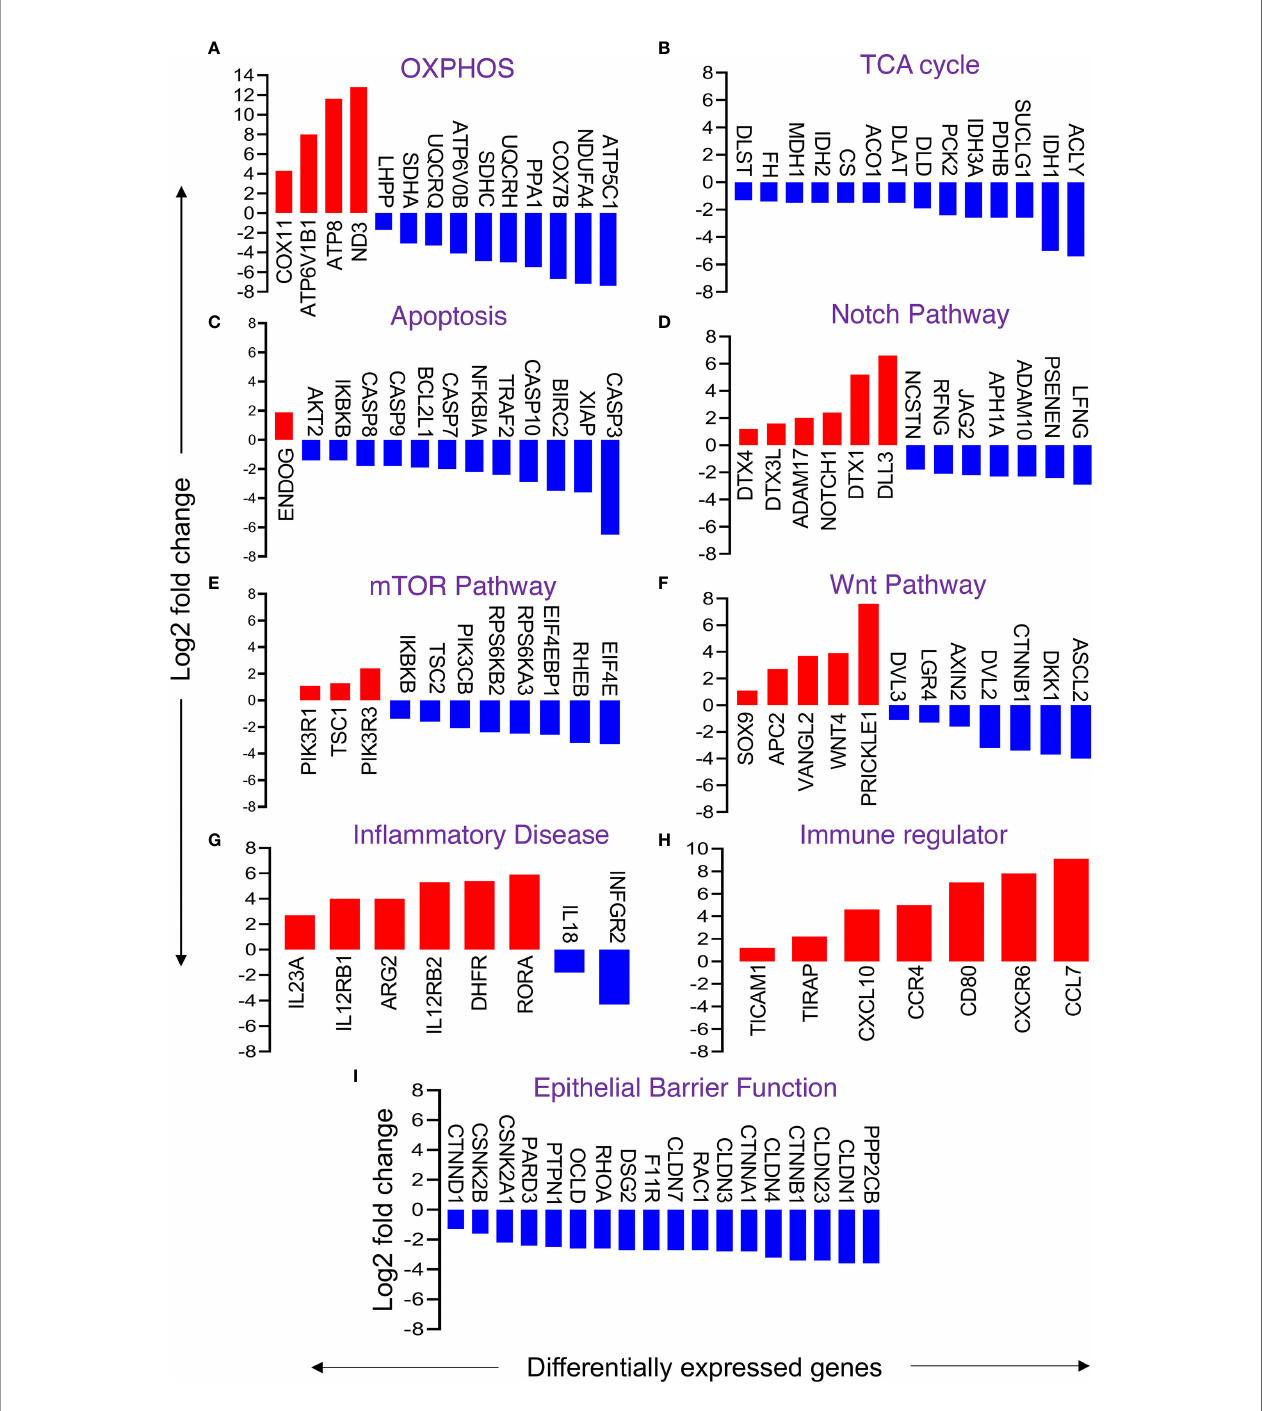
FIGURE 6 | Changes in selective gene expression of primary enteroids isolated from chronically SIV-infected RhMs when compared to SIV-uninfected RhMs . Representative differentially expressed genes responsible for oxidative phosphorylation (OXPHOS) (A) , TCA cycle (B) , apoptosis (C) , Notch pathway (D) , mTOR pathway (E) , Wnt pathway (F) , in fl ammatory disease (G) , immune regulator (H) , and gut epithelial barrier function (I) are shown. Log(2) fold change in gene expression for upregulated and downregulated genes are shown by red and blue bars,